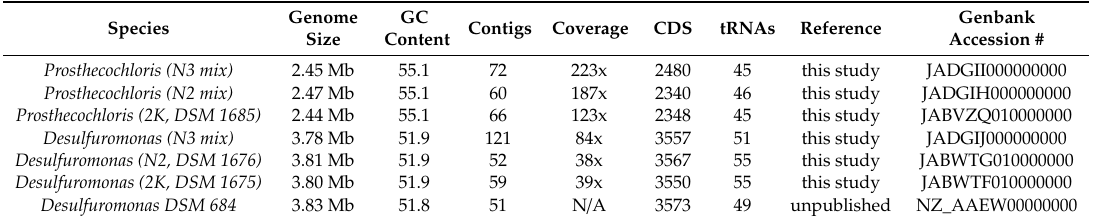
Table 1. Genome characteristics of the Prosthecochloris and Desulfuromonas genomes used in this study. Genome GC Species Contigs Coverage CDS tRNAs Reference Size Content